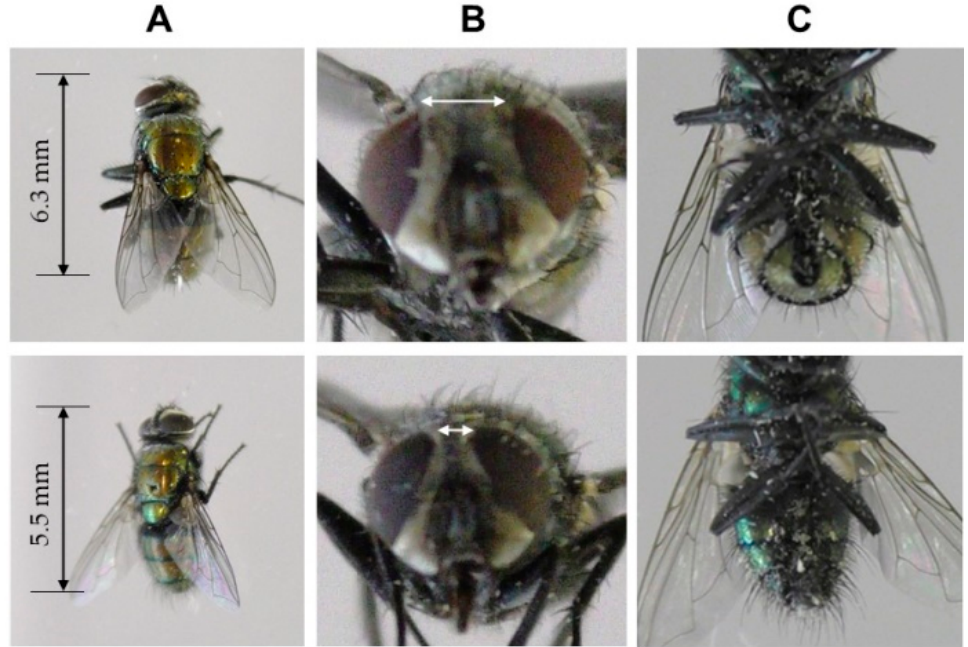
Figure 1. Sexual dimorphism in the external morphology of female ( upper ) and male ( lower row ) adult houseflies ( Musca domestica ). ( A ) Female and male body sizes (dorsal view). ( B ) Female and male eye spacing (front view). ( C ) Female with post-abdomen ovipositor and male with post-abdomen genital appendages (ventral view).